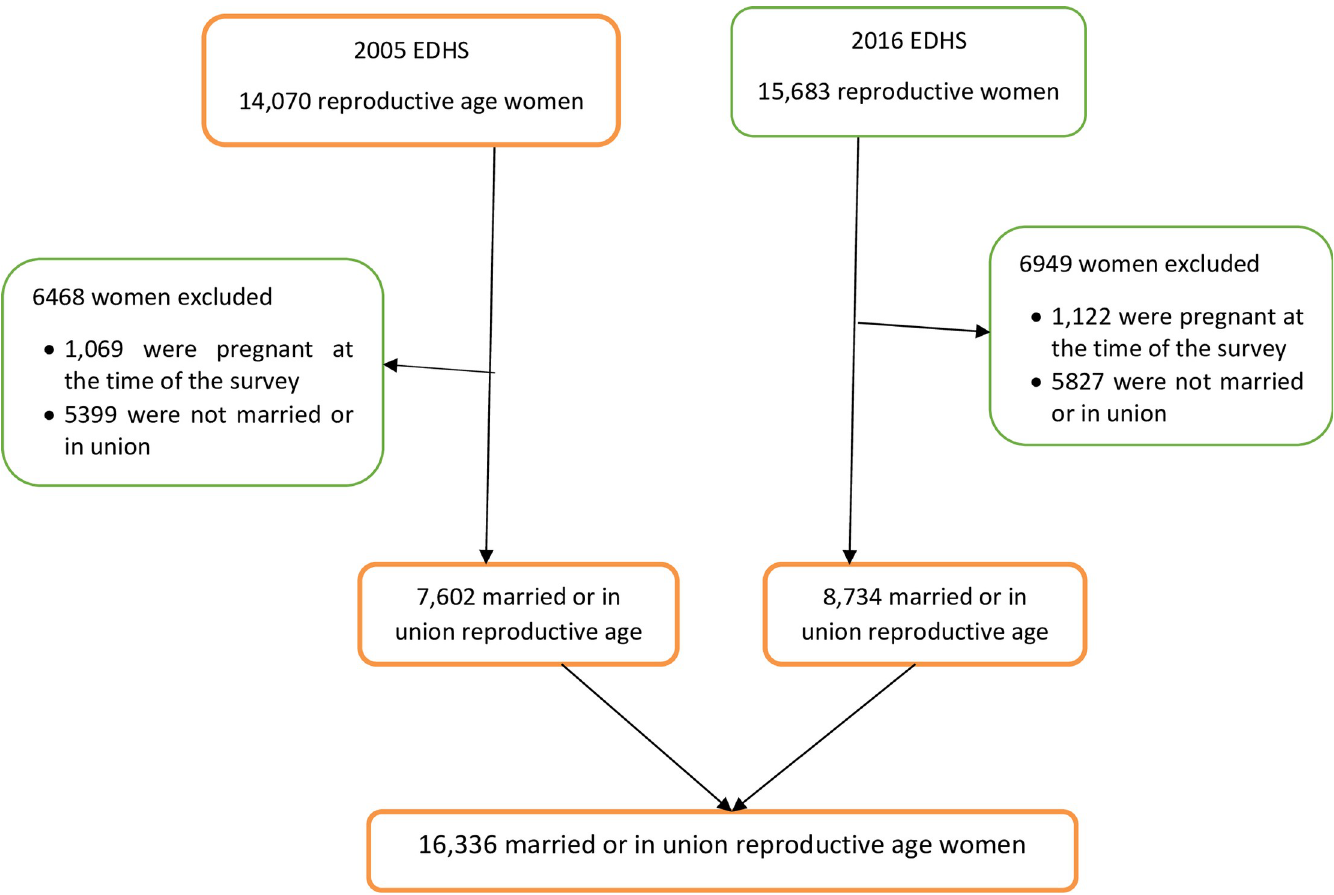
Fig 1. Schematic presentation of the selection of women included in the analysis to identify factors associated with change in LAPM contraceptive methods use in